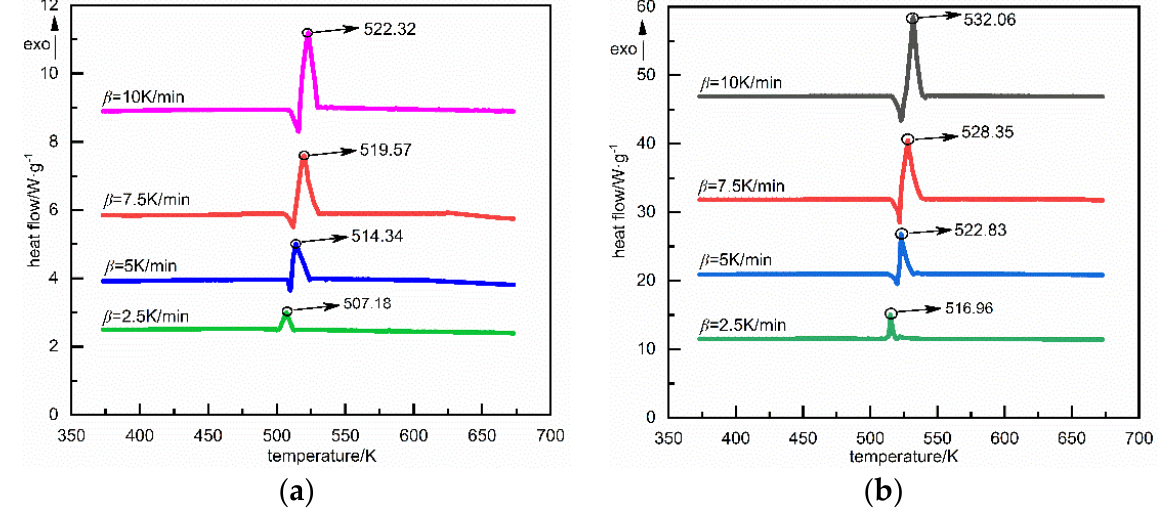
Figure 3. ( a ) DSC curve of ordinary NQ; ( b ) DSC curve of spherical NQ. As shown in Figure 3a,b, both spherical NQ and ordinary NQ have an endothermic peak at about 505 K, indicating that NQ is in a melting endothermic state near this peak, and the spheroidization of NQ does not change the melting point of explosives; at the same heating rate, the exothermic peak of spherical NQ is always larger than that of ordinary NQ, indicating that the spheroidization makes the thermal decomposition of NQ absorb more energy at a higher ambient temperature. At the same time, as the heating rate decreases, the difference between the two NQ exothermic peaks also increases significantly. This is because the spheroidization not only changes the crystal shape of the explosive, but also reduces the internal defects of the nitroguanidine crystal, and increases the probability of hot spot formation in the crystal.